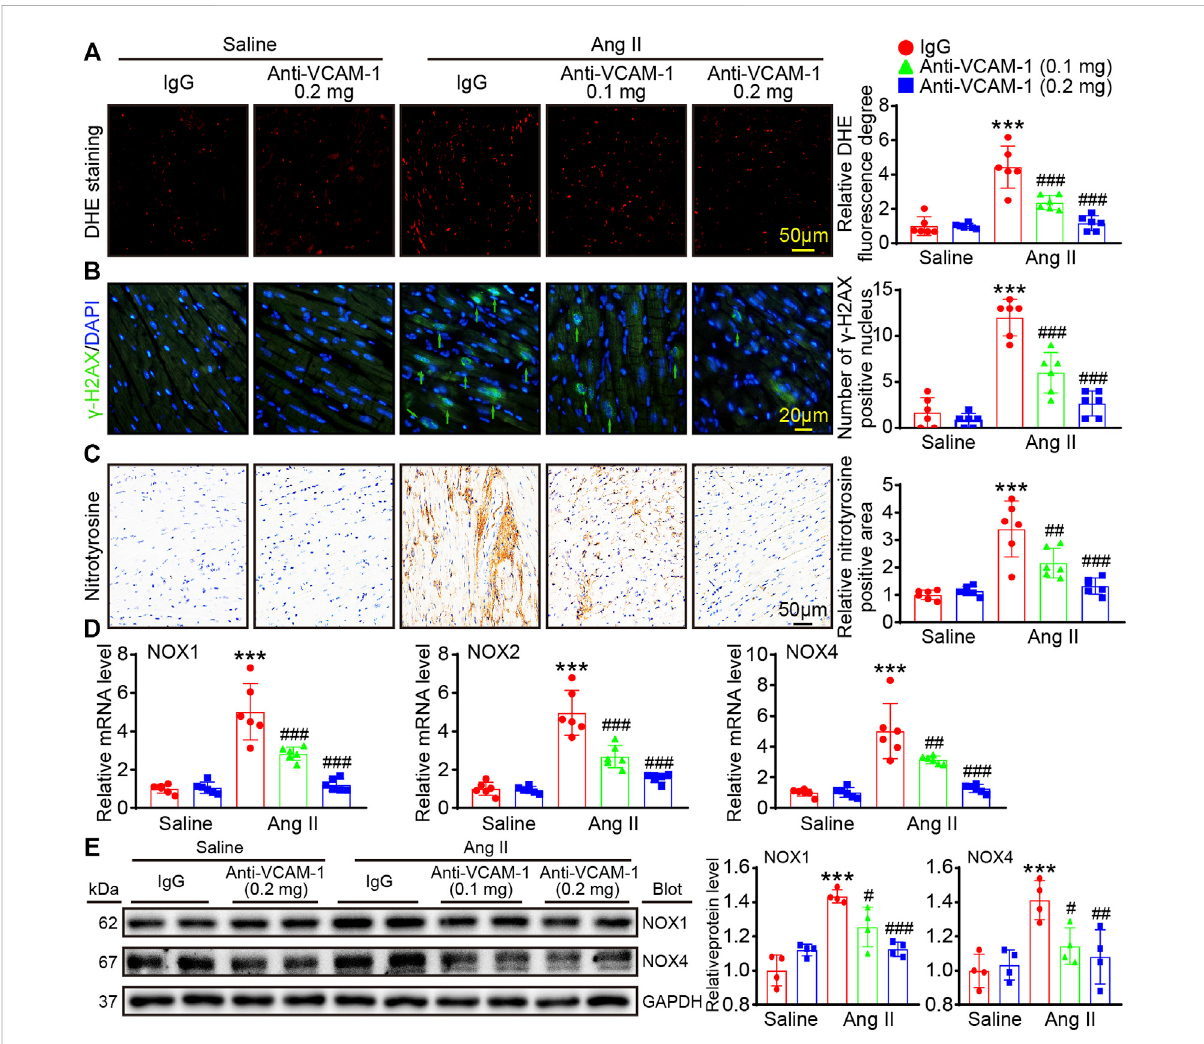
FIGURE 5 Blockade of VCAM-1 reduces Ang II-induced oxidative stress and DNA damage. (A) Immuno fl uorescence staining of heart sections (left). Scale bar:50 μ m.AnalysisoftheDHE fl uorescenceintensity(right, n =6) (B) Immuno fl uorescencestainingofheartsectionswithananti- γ -H2AXantibody (left).Scalebar:20 μ m.Analysisof γ -H2AX-positivenuclei(right, n =6) (C) Immunohistochemicalstainingofheartsectionswithananti-nitrotyrosine antibody (left). Scale bar: 50 μ m. Analysis ofnitrotyrosine-positiveareas (right, n = 6) (D) qPCRanalysisof NOX1, NOX2 and NOX4 expressionin theheart( n =6) (E) Immunoblotanalysis ofNOX1 andNOX4 (left)andanalysisthelevels oftheseproteins(right, n =4).Thedataareexpressedasthe M ± SD, and n represents the number of animals. *** p < 0.001 vs saline + IgG group. # p < 0.05, ## p < 0.01 and ### p < 0.001 vs Ang II + IgG